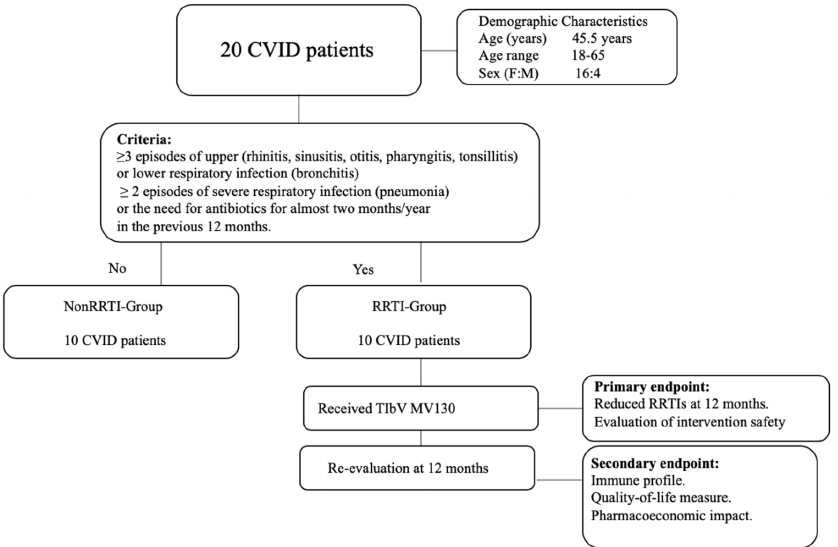
Figure 1. Flow chart of the classification of common variable immunodeficiency (CVID) patients according to clinical criteria.